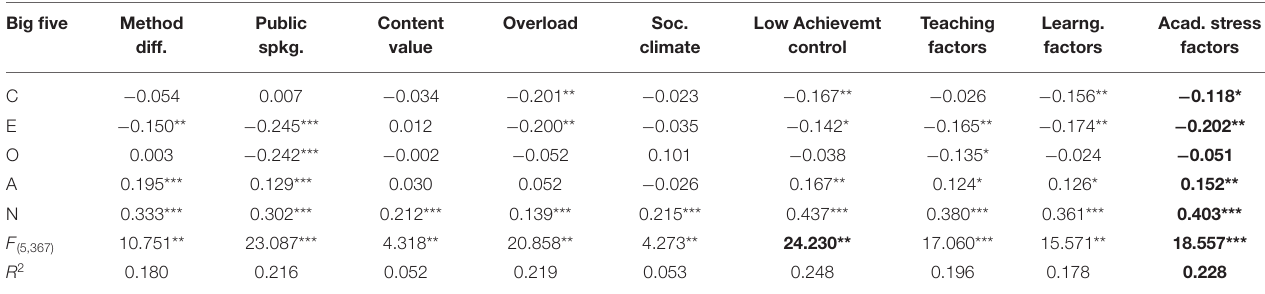
TABLE 3 | Multiple regression between the BF factors, and factors of academic stress ( n = 405). Big five Method